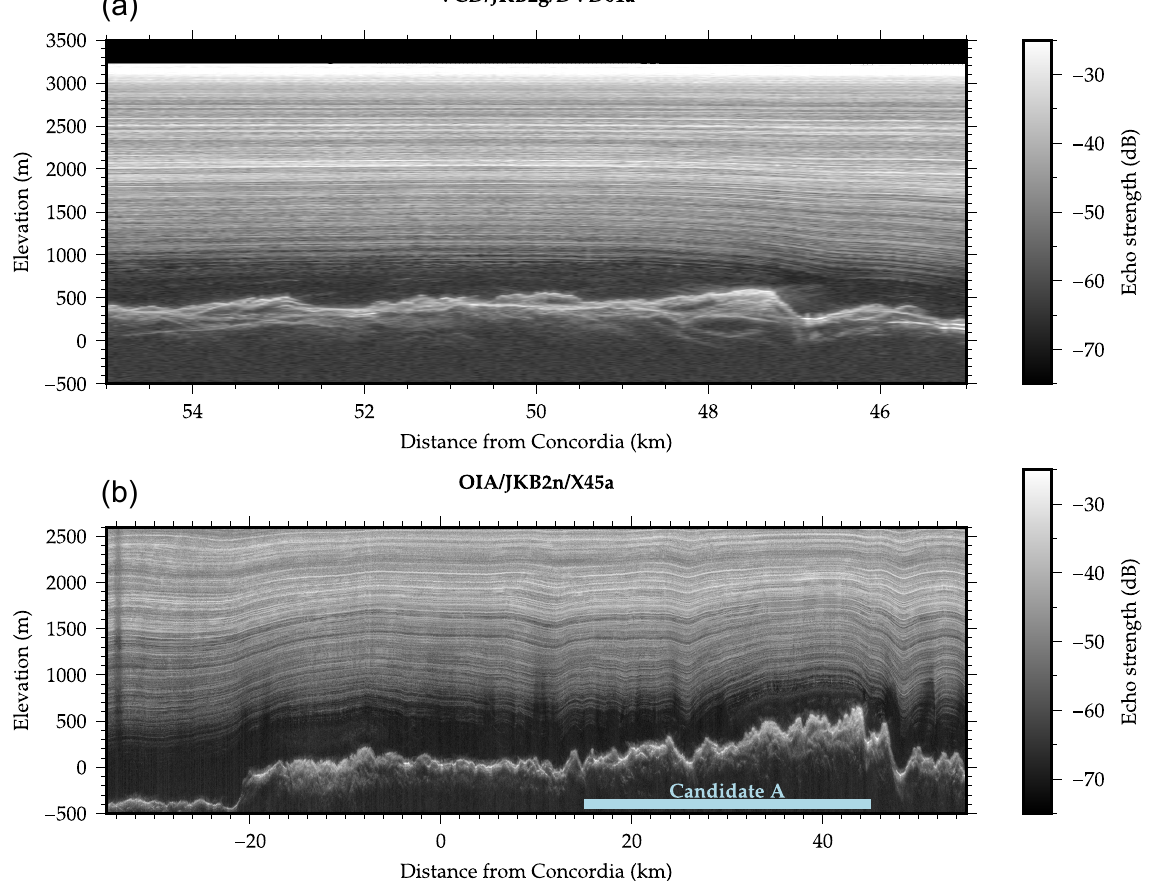
Figure 3. (a) HiCARS2 2D focused and depth corrected radargram along the ice divide across the Candidate A target (line VCD/JKB2g/DVD01a from Blankenship et al., 2014, and shown in green in Fig. 2). Geographic south is to the right, Dome C and ge- ographic north is to the left, color scale is relative power (geometrically corrected) in dB. Near surface layers have superposed surface scattering. No vertical exaggeration. Echoes appearing below the bed are actually coming from up to a kilometer on either side of the track. (b) MARFA line from OIA survey (line OIA/JKB2n/X45a) parallel to VCD/JKB2g/DVD01a, showing distance from Concordia, the location of Candidate A, and the EPICA/DMC site. Vertical exaggeration is 25 × , and orientation is the same as